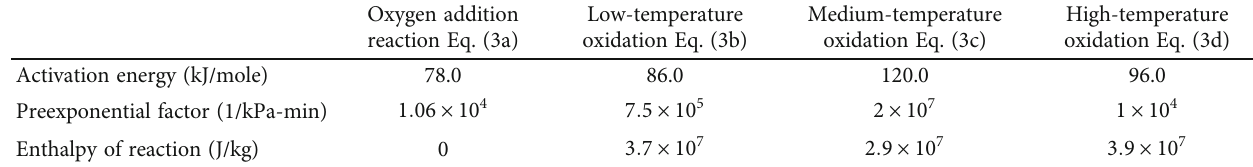
Figure 6: Relative permeability curves used in the simulation study: (a) two-phase water ( K . Three-phase relative permeability is computed using the Stone 2 relationship. and oil ( K rog ) Table 2: Optimized kinetic parameters through kinetic cell simulation.